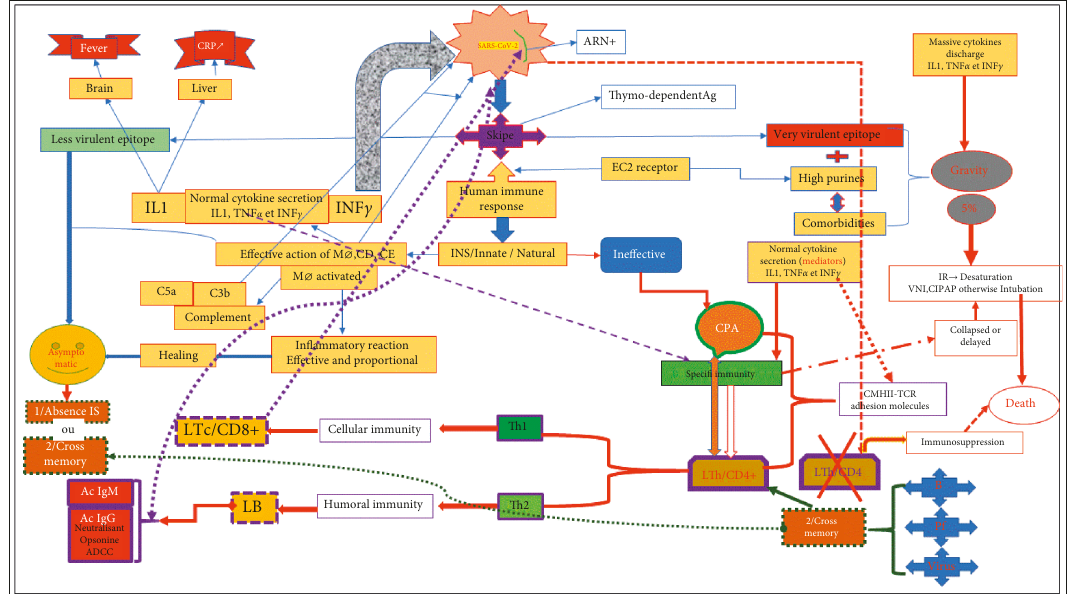
Figure 6: Immune response of the infected host and the different situations (Source: this study).